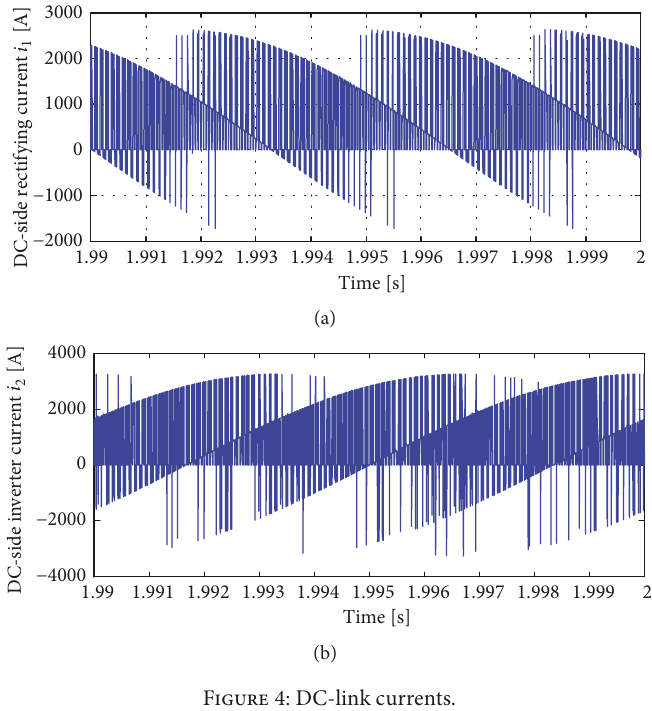
Figure 4: DC-link